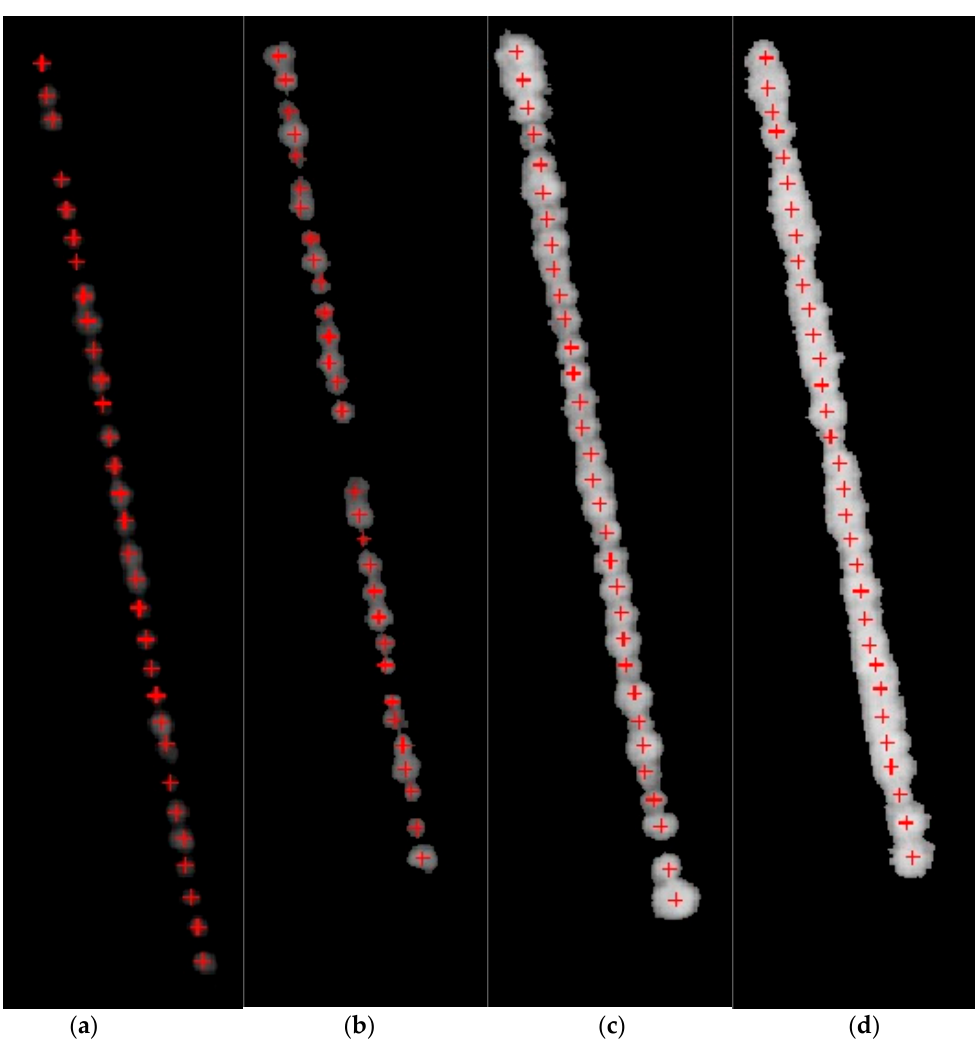
Figure 8. ( a – d ) Identification of center points using Algorithm 1.